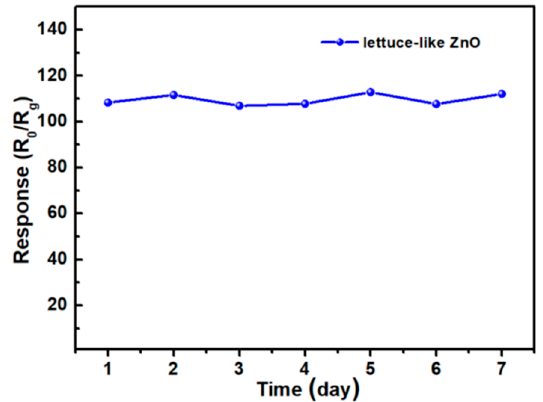
Figure 4. The long-term stability of the lettuce-like ZnO sensor to 100 ppm H 2 S.